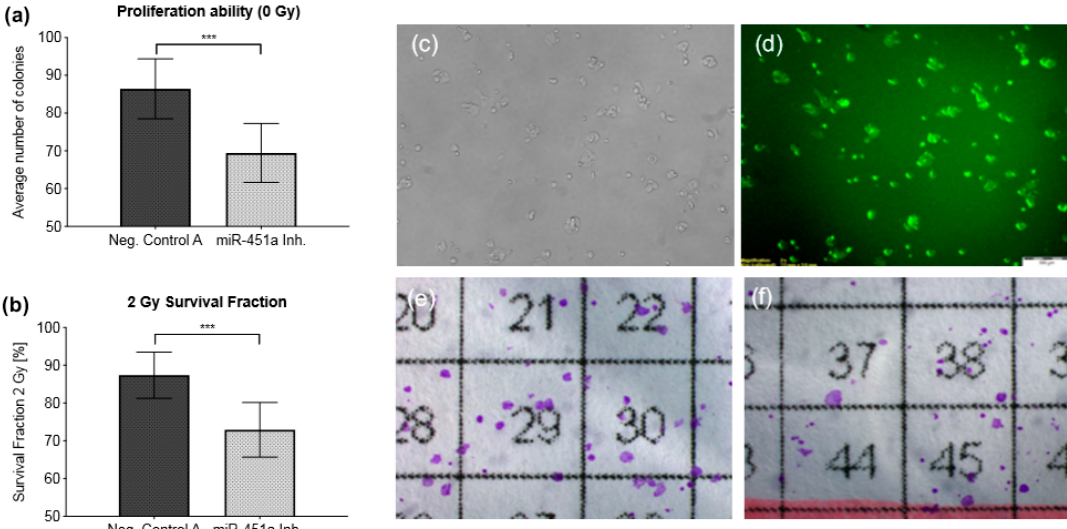
Figure 2. Inhibition of miR-451a in OE19 cells. ( a ): Pooled average numbers of colonies from n = 3 independent irradiation experiments formed after 12 days in non-irradiated cells transfected with either a miR-451a inhibitor or a negative control (Negative Control A) cells. ( b ): Inhibition of miR-451a enhances radiosensitivity. SF was assessed via clonogenic assay after irradiation with 2 Gy in n = 3 independent experiments. Results are presented as mean ± SD. ( c , d ): 5 ′ -fluorescein-labeled Negative Control A demonstrates siRNA uptake by fluorescence microscopy to monitor transfection efficiency. Pictures were taken 48 h after transfection. ( e , f ): Results of the clonogenic assay after an incubation period of 12 days post irradiation with 2 Gy. ( e ): Negative Control A. ( f ): miR-451a-